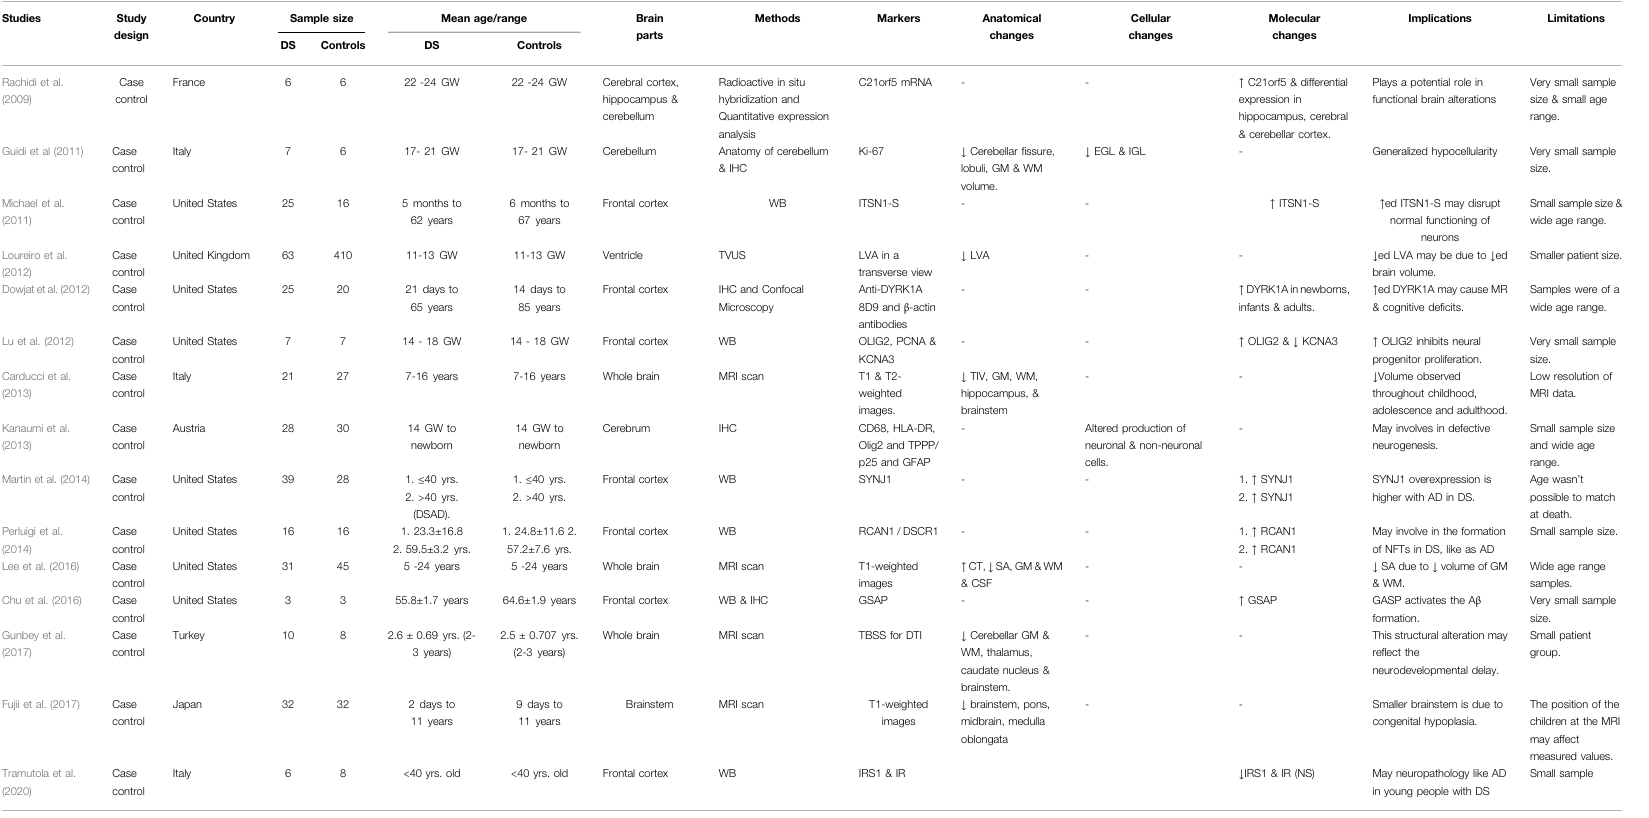
TABLE 1 | ( Continued ) Summary of neuropathogenesis at anatomical, cellular, and molecular levels in human.